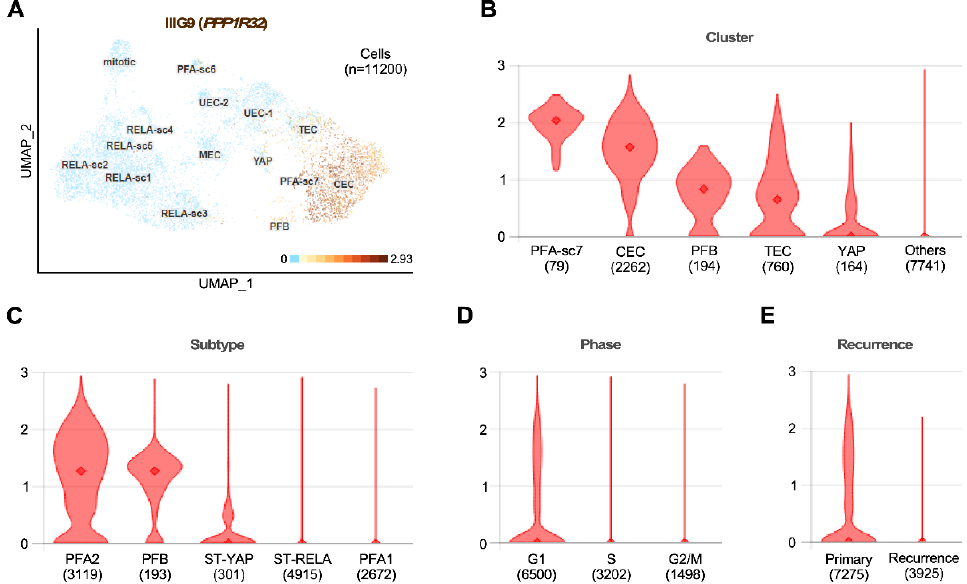
Figure 5. IIIG9 expression is restricted to ciliated ependymoma cells of the posterior fossa. ( A ). Har- mony alignment projection of scRNA-seq analysis of 26 pediatric patients with ependymoma (EPN). IIIG9 ( PPP1R32 ) expression is shown in the brown color range and corresponds to the values gen- erated by the adaptive threshold low-rank approximation (ALRA). ( B – E ). IIIG9 expression ALRA range is shown by cluster ( B ), subtype ( C ), phase ( D ), and recurrence ( E ) The number of cells in each selec- tion is placed in brackets ( n = 11200 cells). Seven subgroup clusters of posterior fossa group A (from PFA-sc1 to PFA-sc7), five subgroup clusters of ZFTA-RELA group (from RELA-sc1 to RELA-sc5), one posterior fossa group B (PFB), and one YAP-MAMLD1 group (YAP) are shown. Five PFA subgroup clusters correspond to ciliated EPN cells (CEC), transporter EPN cells (TEC), mesenchymal EPN cells (MEC), and undifferentiated EPN cells 1 and 2 (UEC-1 and EC-2, respectively); cells are in mitosis (mitotic). Uniform manifold approximation and projection (UMAP) was used for classification. The database was generated by Gillen and colleagues [105] and is available in the browsable web resource of the full EPN scRNA-seq dataset at the Pediatric Neuro-oncology Cell Atlas